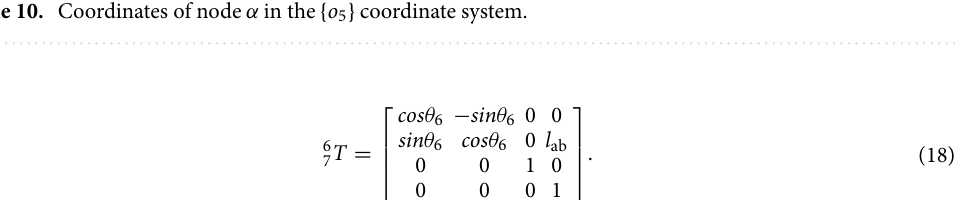
Table 10. Coordinates of node α in the { o 5 } coordinate system.